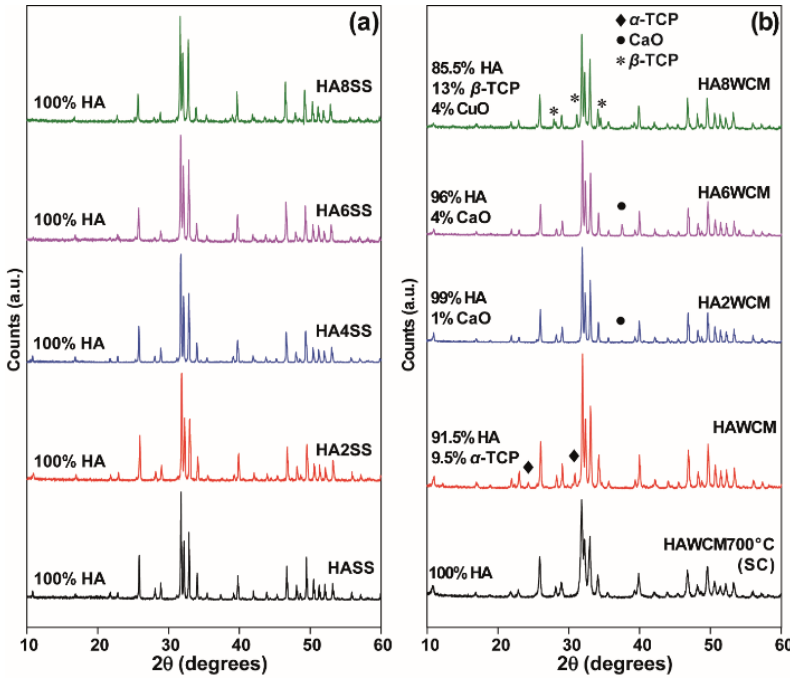
Figure 2. Powder X-ray diffraction (PXRD) data of the undoped and Cu-doped hydroxyapatite (HA) samples prepared by ( a ) solid-state reaction, and ( b ) the wet chemical synthetic routes.